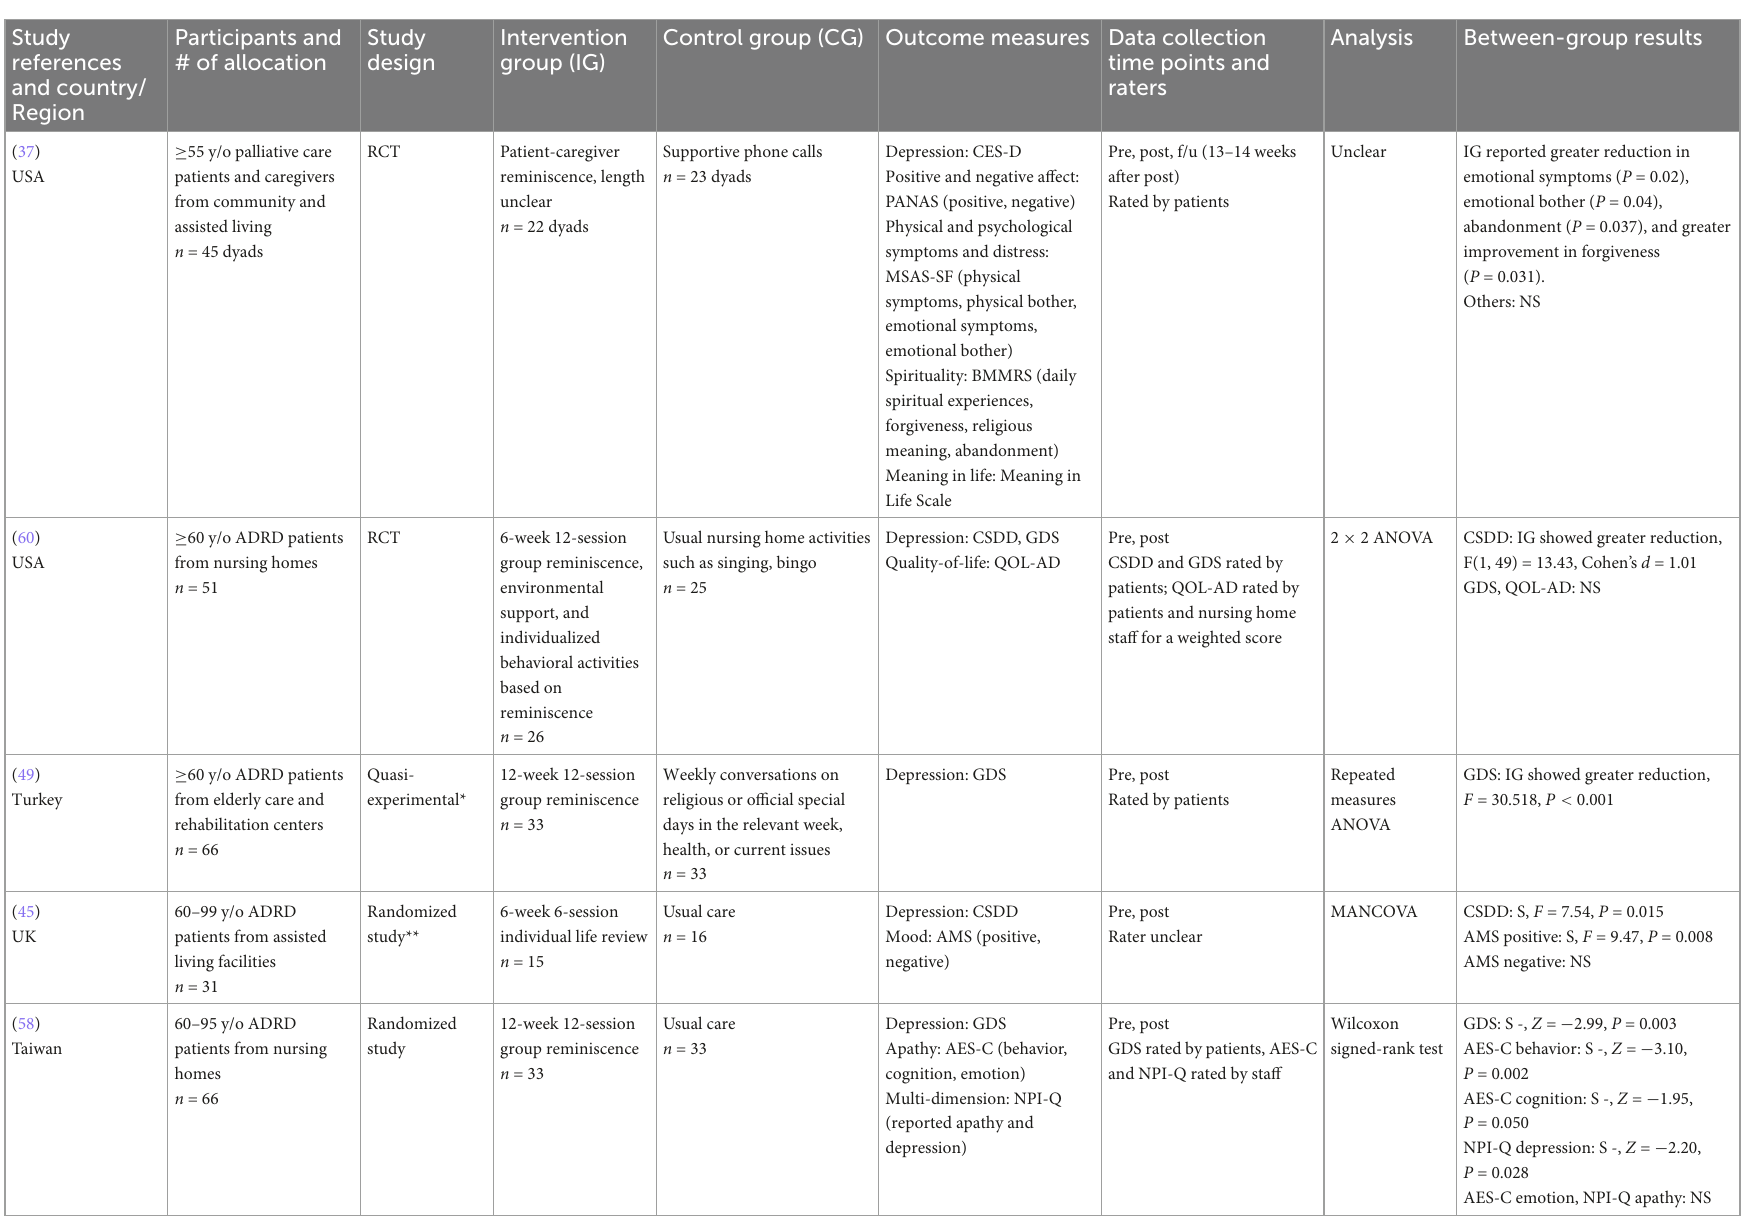
TABLE 1 Characteristics of included